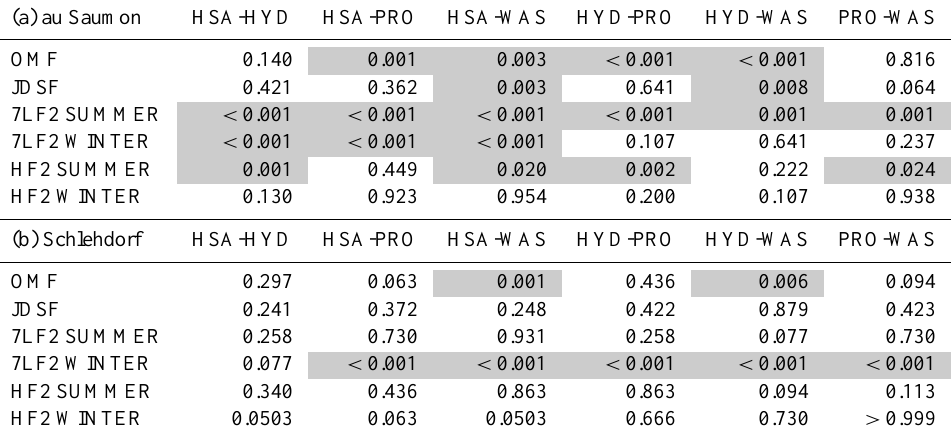
Table 4. Results of Wilcoxon test comparing pairs of hydrological models for (a) au Saumon , and (b) Schlehdorf. The p-value is shown and the shaded area indicates a rejection of the null hypothesis at significance level of